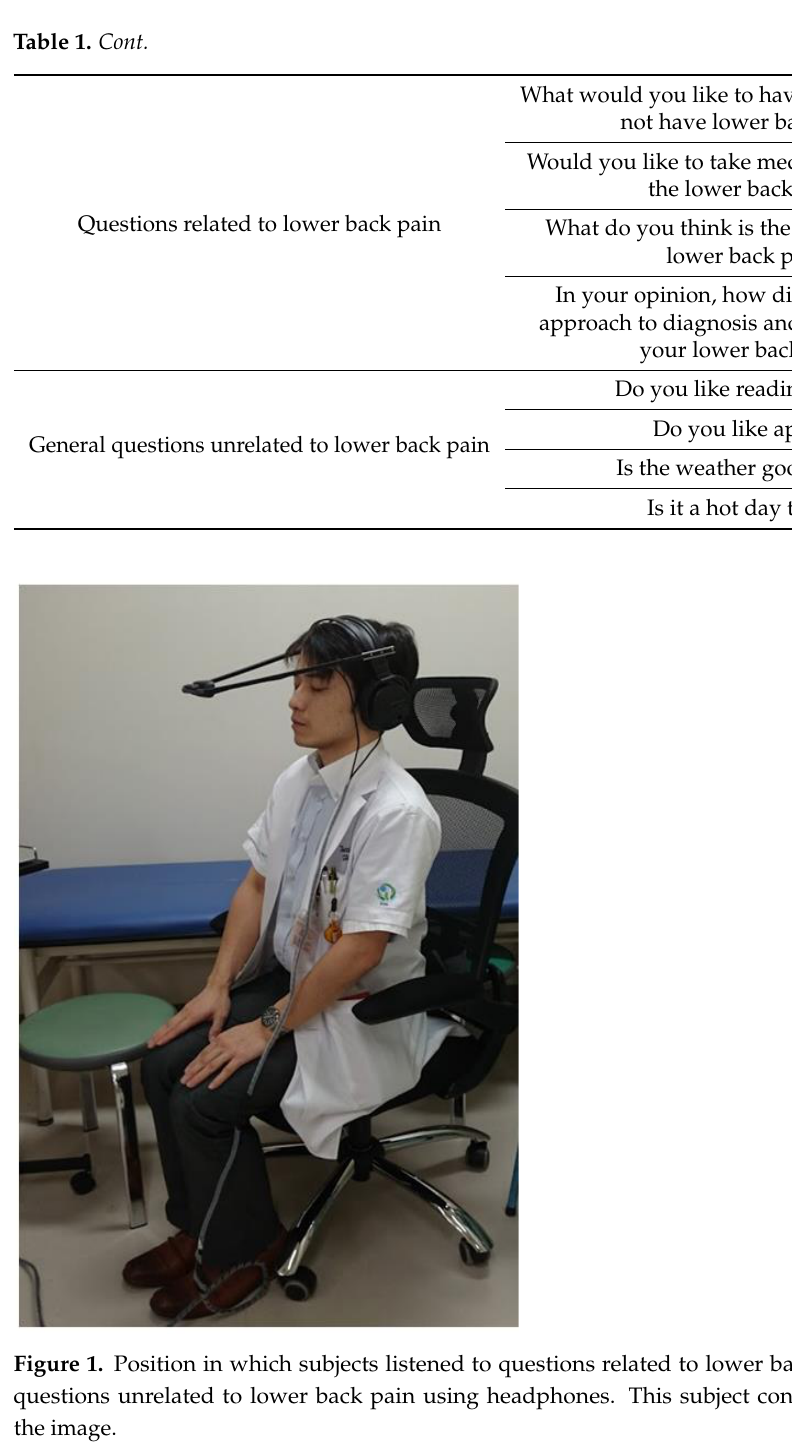
Table 1. Questions for study subjects.